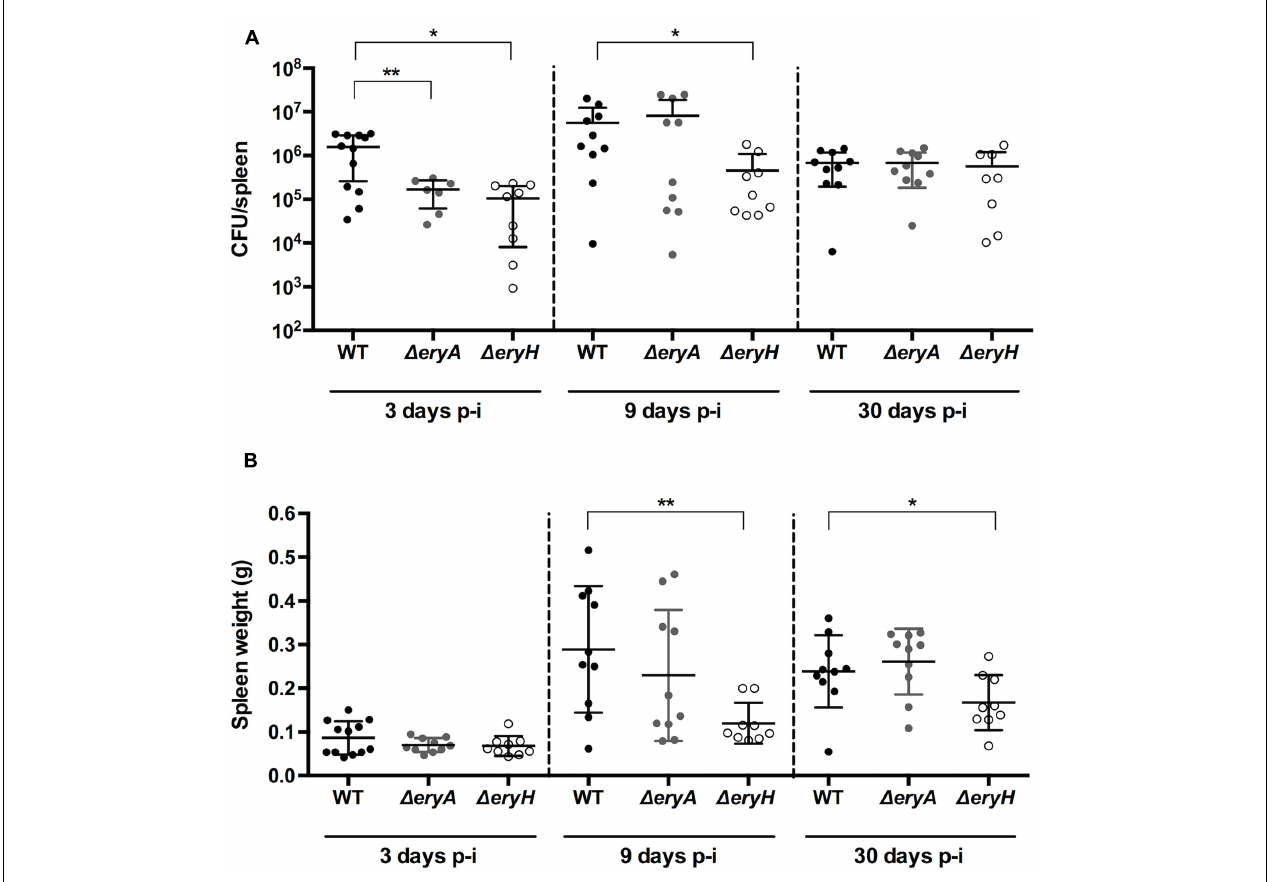
FIGURE 4 | The B. abortus erythritol catabolic mutants (cid:49) eryA and (cid:49) eryH are attenuated in C57BL/6 mice. Mice were infected with 5 × 10 4 CFU, and CFU in the spleen (A) and spleen weights (B) determined at the indicated intervals. Each dot represents the CFU counts of one individual mouse, and bars the mean ± standard deviation ( ∗ p < 0.01; ∗∗ p < 0.001; Mann–Whitney